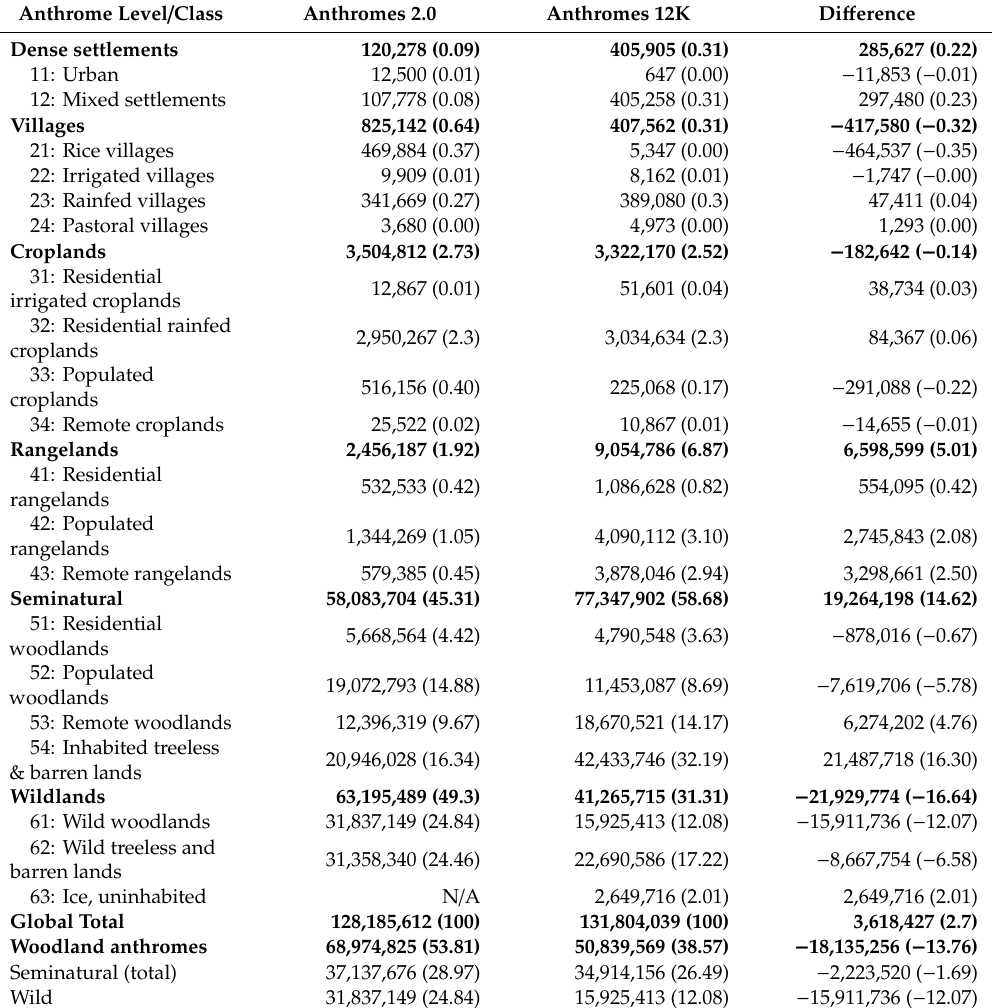
Table 4. Comparison of 1700 CE anthrome levels ( bold text ) and classes in Anthromes 12K and computed by subtracting Anthromess 2.0 from Anthromes